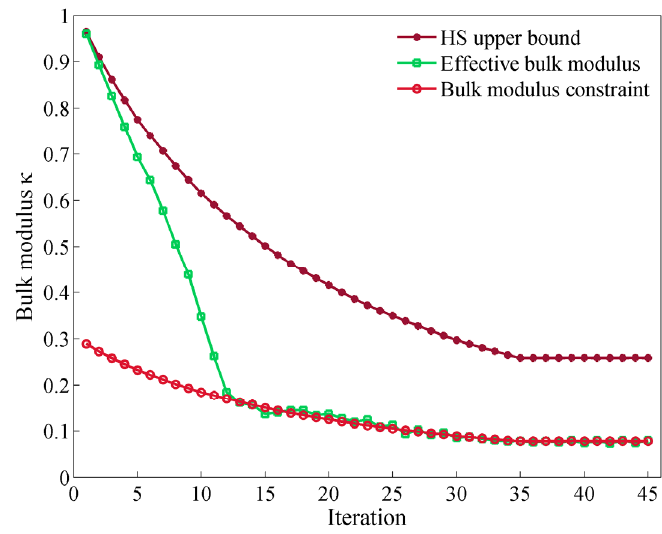
Figure 5. Evolution histories of the effective bulk modulus, bulk modulus constraint and corresponding HS upper bound in the optimization process with constraint ratio β κ = 0.3.